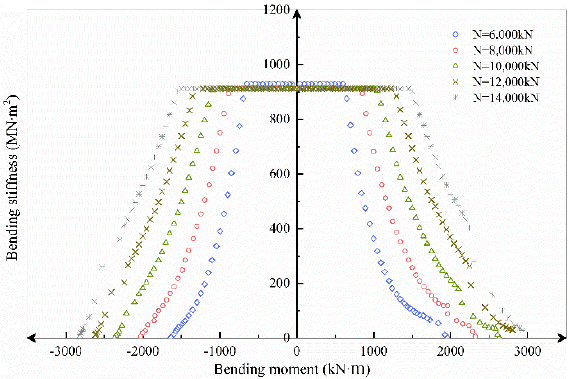
Figure 17. K θ –M curves under different axial forces.